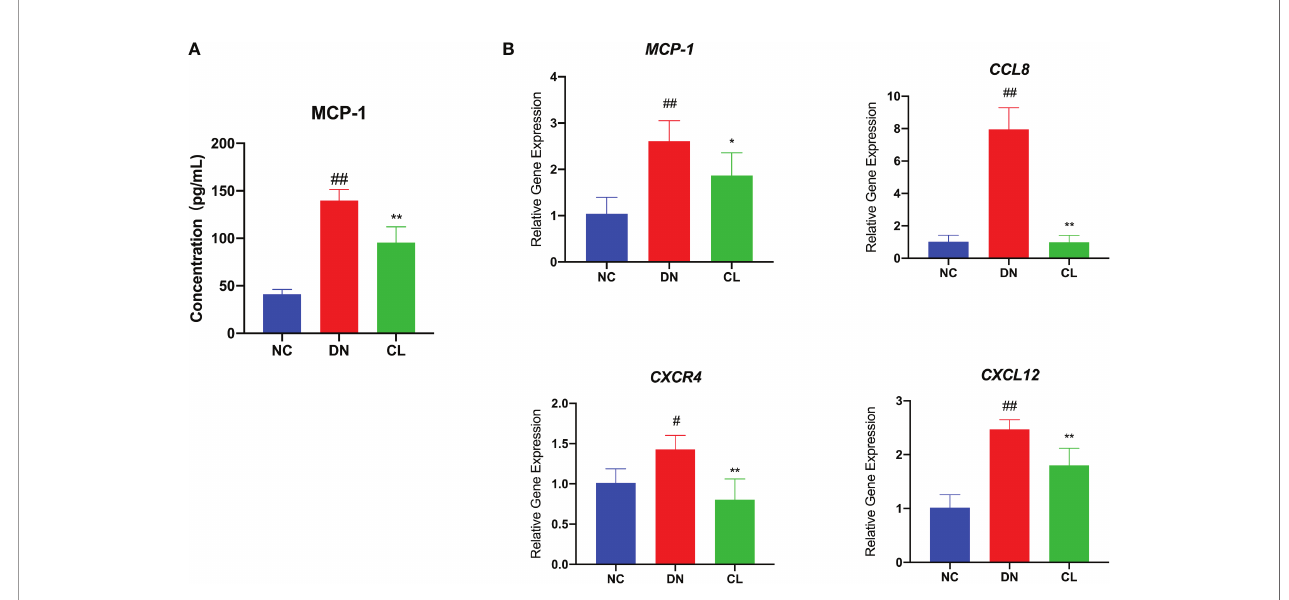
FIGURE 4 | Macrophage depletion signi fi cantly reduces the levels of chemokines in blood serum and tissues. (A) MCP-1 level in mouse serum. (B) mRNA expression of various chemokines in mouse kidney tissue. NC, normal control group (db/m); DN, diabetic nephropathy group (db/db), CL treatment: db/db + clodronate liposome treatment. # p < 0.05 vs. the normal group, ## p < 0.01 vs. the normal group, *p < 0.05 vs. the DN group, **p < 0.01 vs. the DN